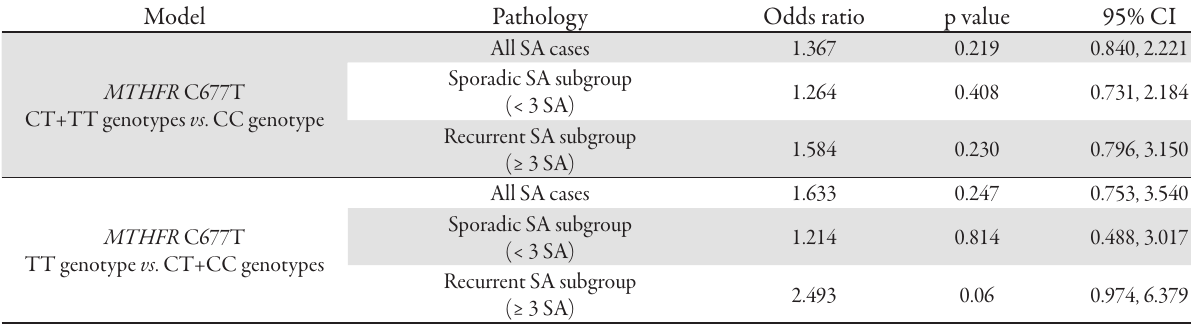
Tab. 3. Risk analysis for spontaneous abortion (SA) compared to controls